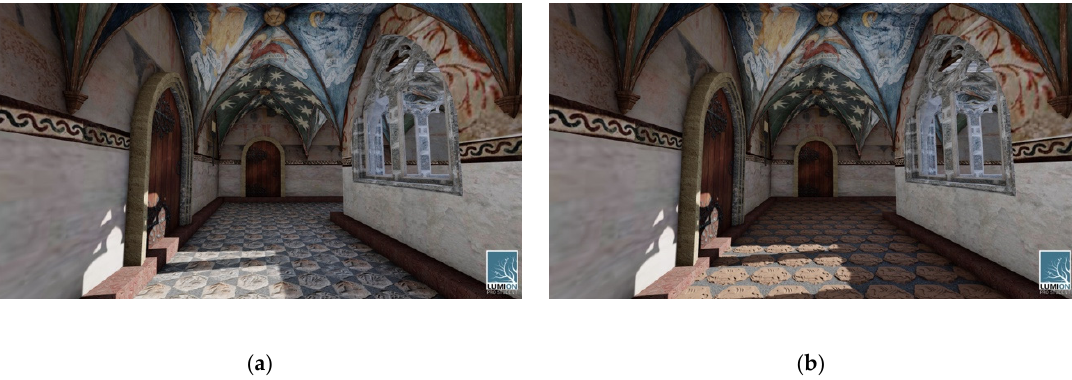
Figure 15. The gothic tiled floor created using adapted textures only ( a ) and using the processed terrestrial laser scanning (TLS) model ( b ) for comparison.